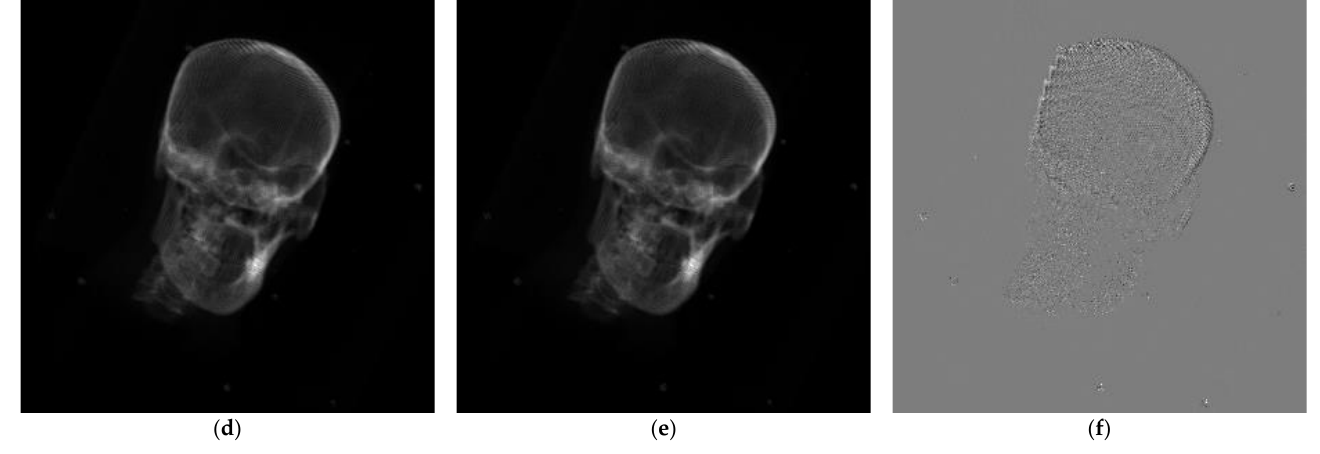
Figure 4. Results of Experiment 1: ( a ) reference image 1; ( b ) DRR image based on WSHGD registration; ( c ) difference image after registration based on the WSHGD; ( d ) reference image 1; ( e ) DRR image registered based on WHGD; ( f ) difference image after registration based on the WHGD.